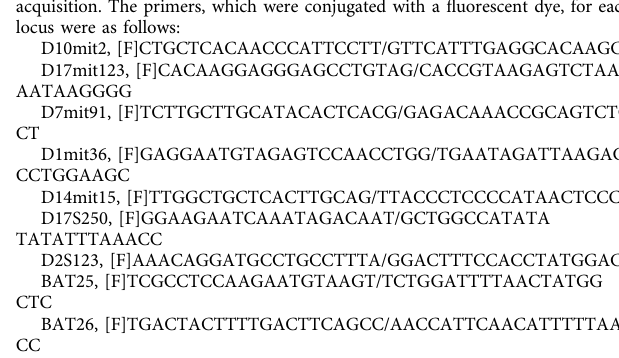
Fig. 7 Model. a Cells that accumulate replication stress-associated DSBs are at a higher risk of genomic destabilization of either CIN or MSI. Genomic destabilization is associated with induction of mutations, leading to clonal evolution of cells with defects in cellular defense systems. b CIN is caused when replication stress-associated DSBs are not repairable, whereas MSI arises in association with erroneous DSB repair by MMEJ. Hypermutation is also induced in MMR-de fi cient